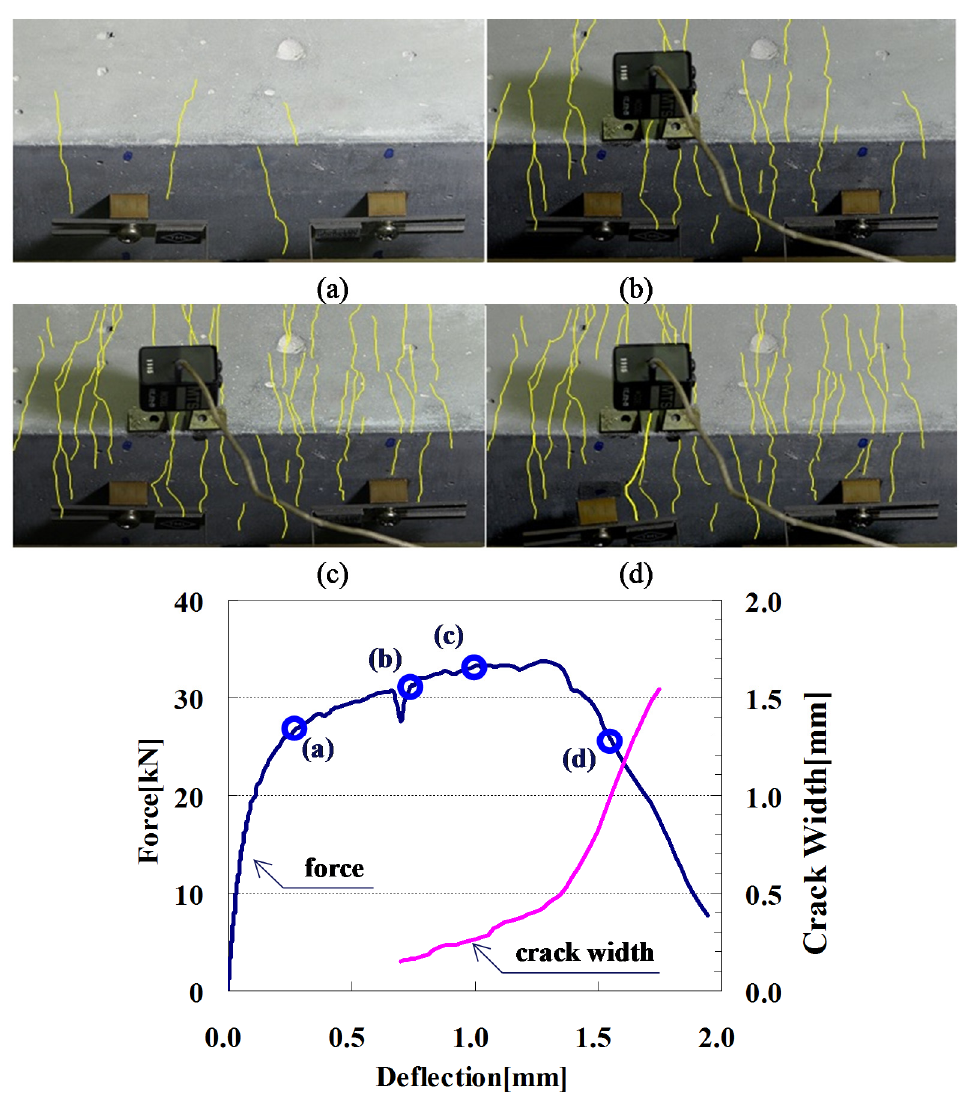
Figure 5. Load–deflection relationship and cracking behavior of a HPFRCC beam. ( a ) initial cracking stage; ( b ) crack gauge attached; ( c ) distributed fine cracks; ( d ) localized